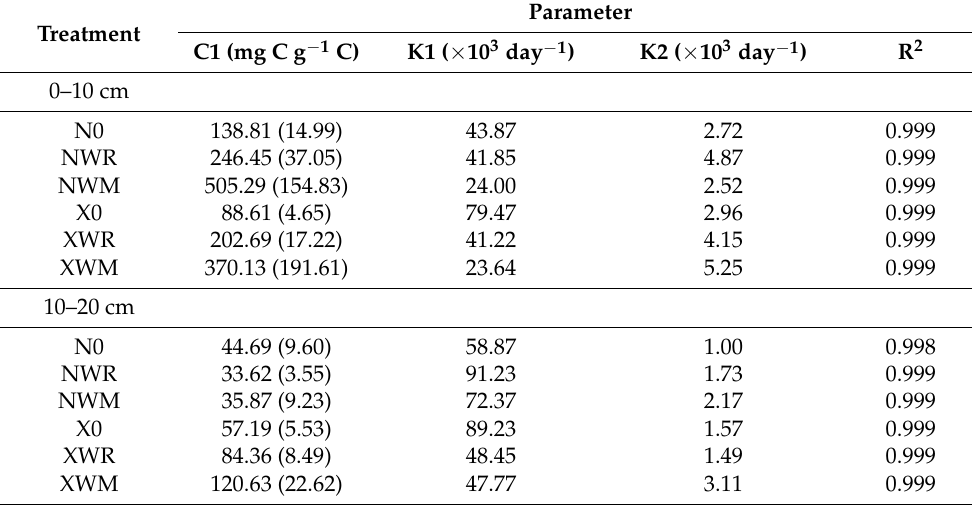
Table 6. Parameter values obtained for the carbon mineralization model (double-exponential model) fitted to cumulative carbon mineralization data for the laboratory incubations (soil samples with straw addition).